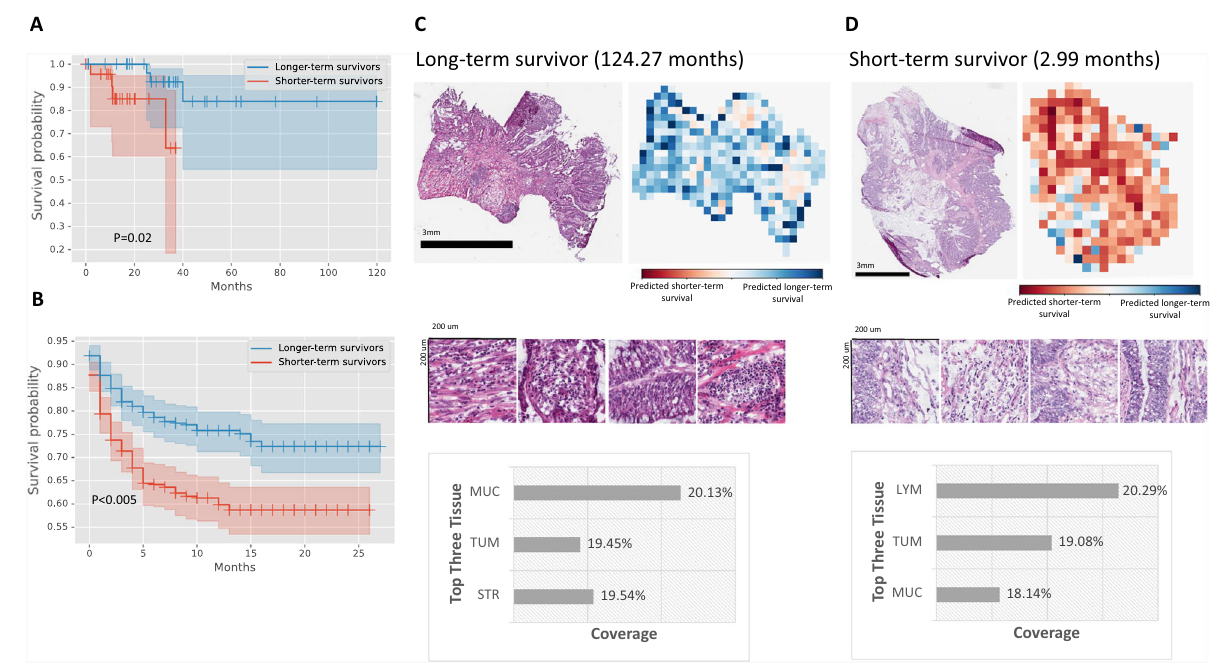
Fig. 3 | Quantitative histopathology imaging predicts stage I and II colorectal cancer patients ’ progression-free survival outcomes. A MOMA-trained models differentiate patients with early relapse or death from those with longer progression-free survival using histopathology images (two-sided log-rank test P - value=0.02). B Wesuccessfullyvalidateourmodelsusingtheindependentexternal validation set from the Nurses ’ Health Study and Health Professionals Follow-up Study cohorts (two-sided log-rank test P -value<0.005). C Interpretation of the